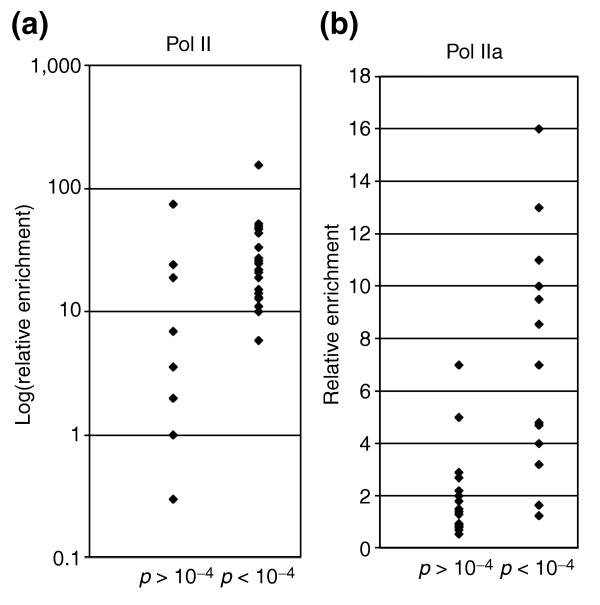
Enrichment of selected genomic regions in ChIP. (a) PolII ChIP; (b) PolIIa ChIP. Real-time PCR relative enrichment ratios for selected regions are found to be enriched more often with p-values below 10-4. These regions include both intra- and intergenic locations as listed in Additional data file 8.